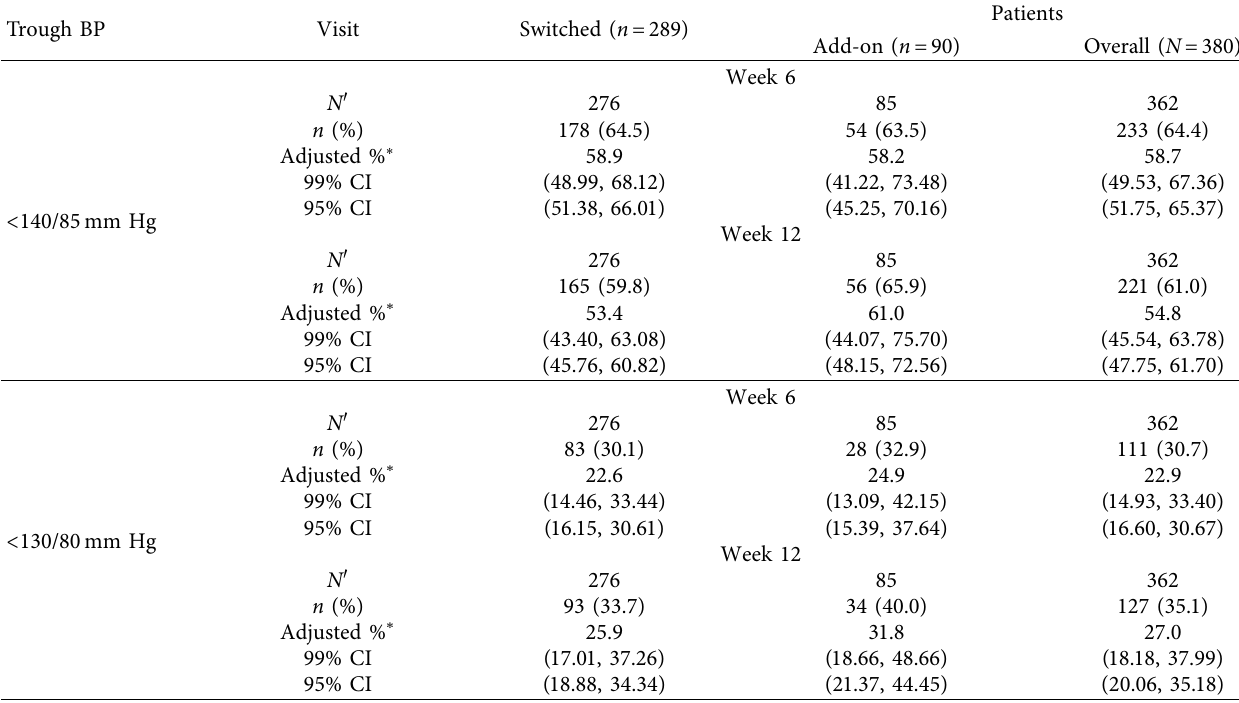
Table 2: Percentage of patients with trough BP < 140/85mm Hg, BP < 130/80mm Hg, and BP 198 < 140/90 mm Hg using GEE (logistic regression model): FAS and